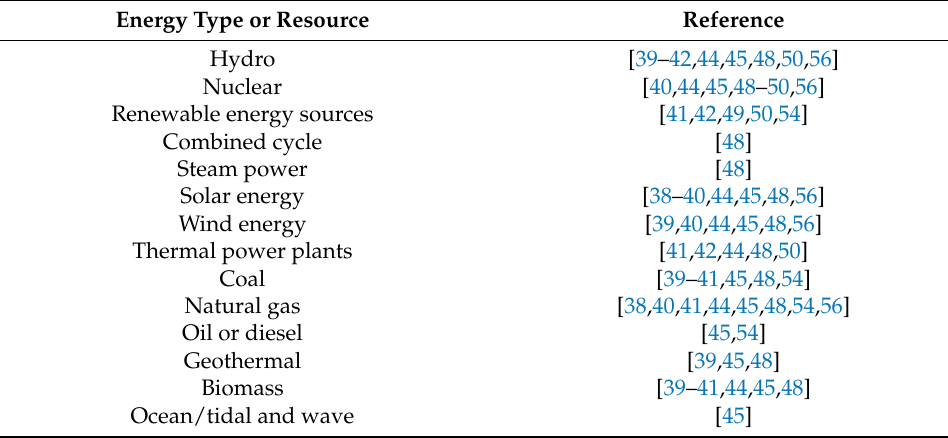
Table 1. Energy types or resources in the